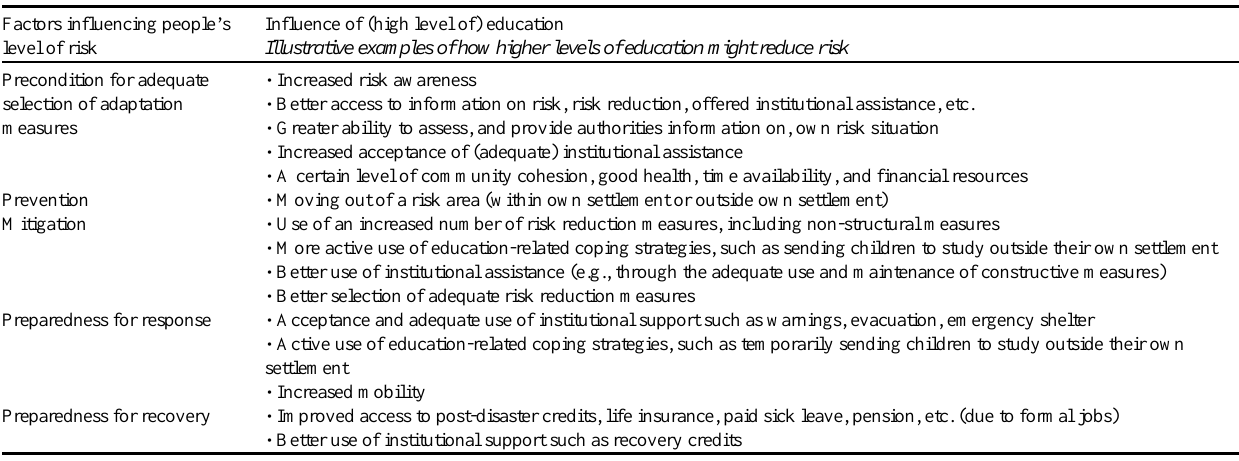
Table 4. Influence of education on people’s adaptive